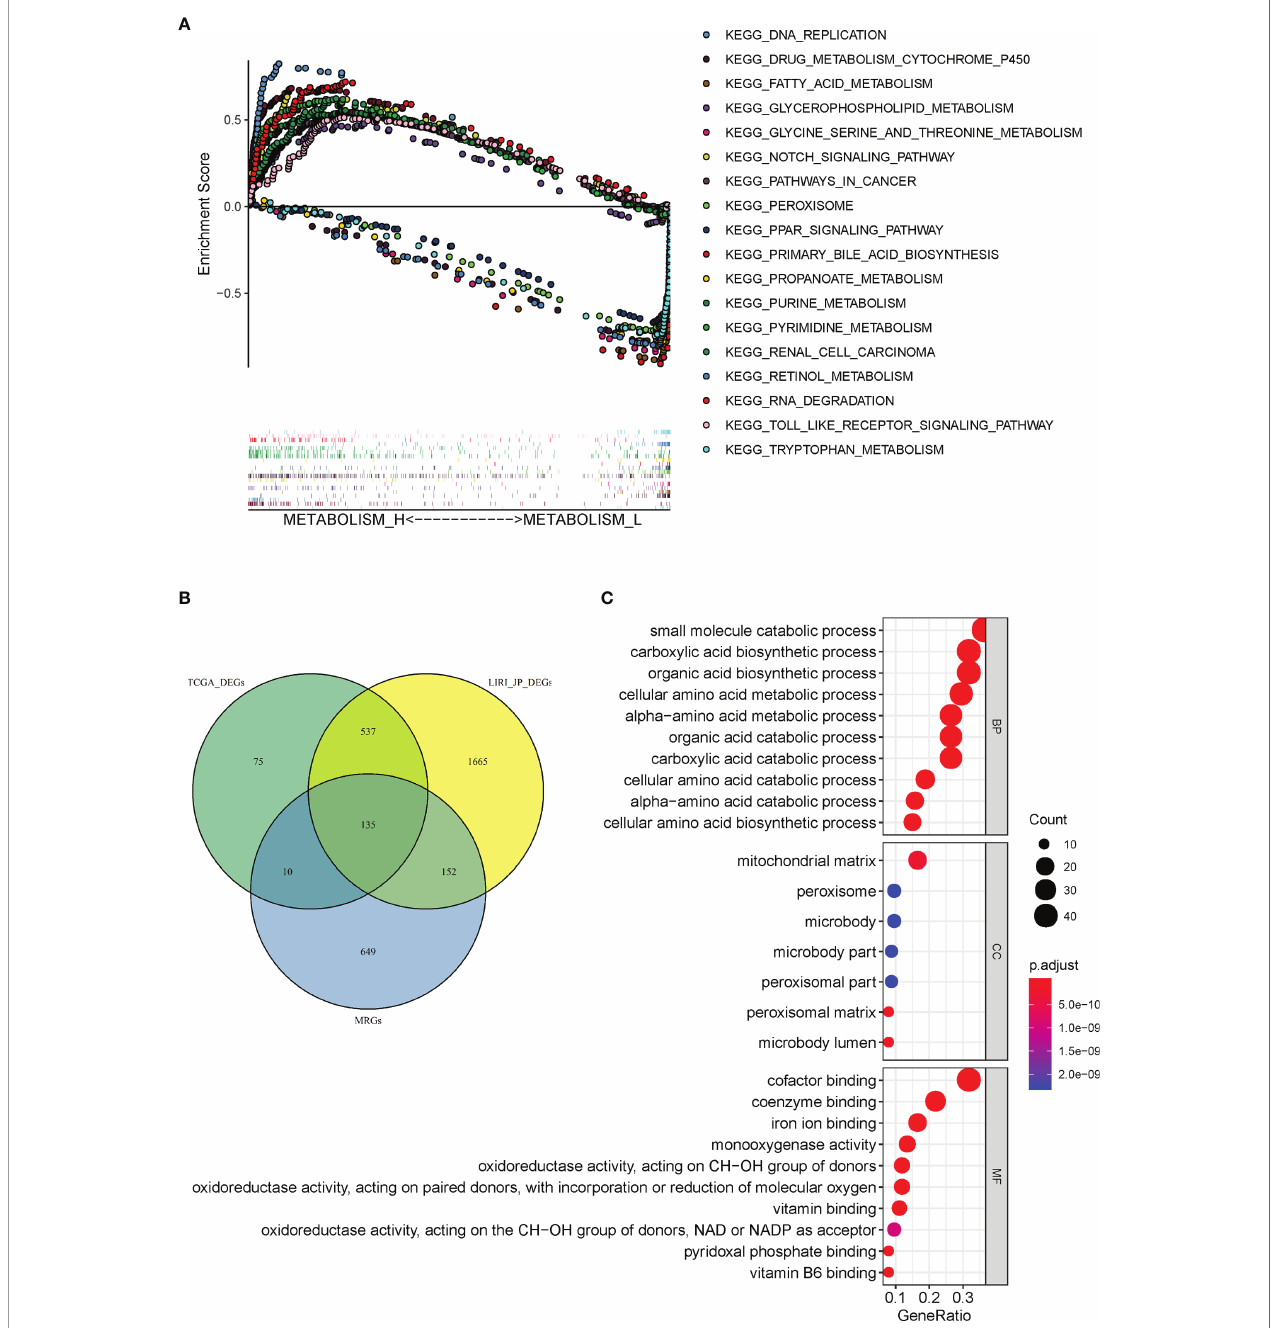
FIGURE 6 | Gene set enrichment and functional enrichment analyses. (A) KEGG pathways enriched in Metabolism_H and Metabolism_L, respectively. (B) A Venn diagram showed 135 DEMGs were overlapped among TCGA_ DEGs, LIRI_JP_DEGs, and MRGs. (C) KEGG pathways in Immunity_H and